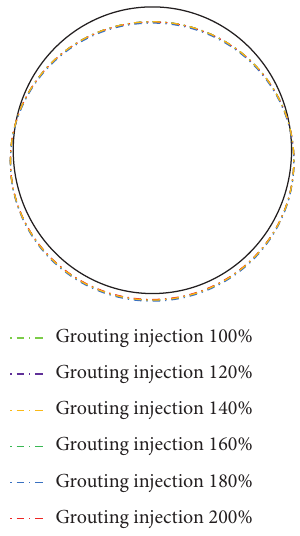
Figure 14: Segment deformation under different grout injection rate